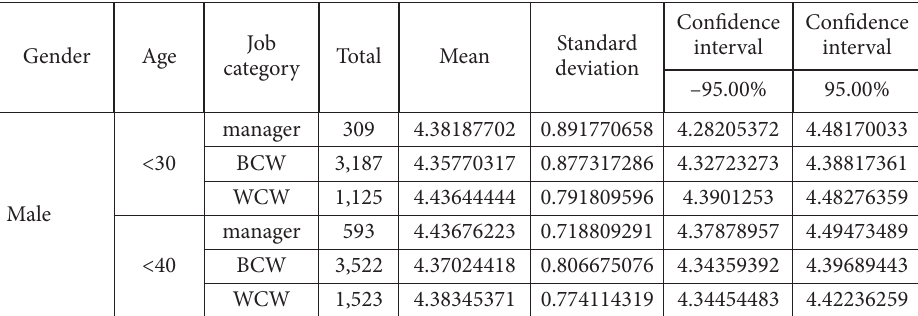
Table 6. Descriptive statistics of the motivation factor fair appraisal